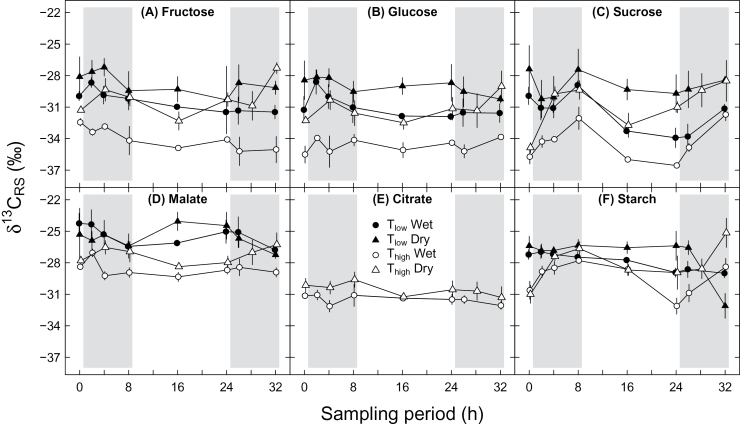
Daily cycles of the carbon isotopic composition of different leaf respiratory carbon sources (δ
13
C
RS) under different environmental conditions during the sampling period: (A) fructose, (B) glucose, (C) sucrose, (D) malate, (E) citrate, and (F) starch. Potato plants were treated with a combination of Tlow (low temperature; closed symbols), Thigh (high temperature; open symbols), and wet (circles) or dry (triangles) conditions. Results for fructose are affected by co-elution with other compounds. Grey areas indicate nighttime. Means ± SE are given (n=2–3).